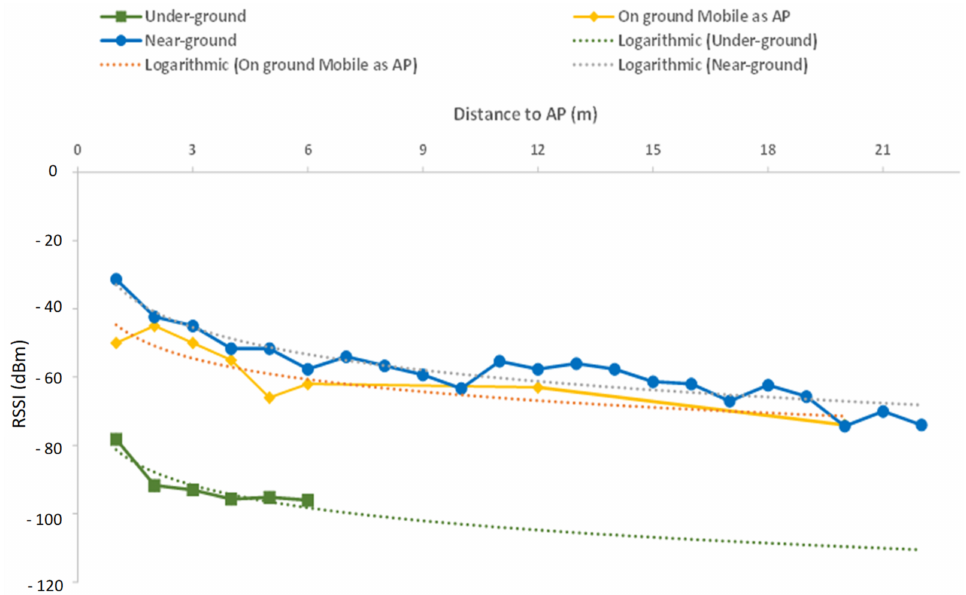
Figure 20. Comparison of network coverages with measured data using a mobile as the